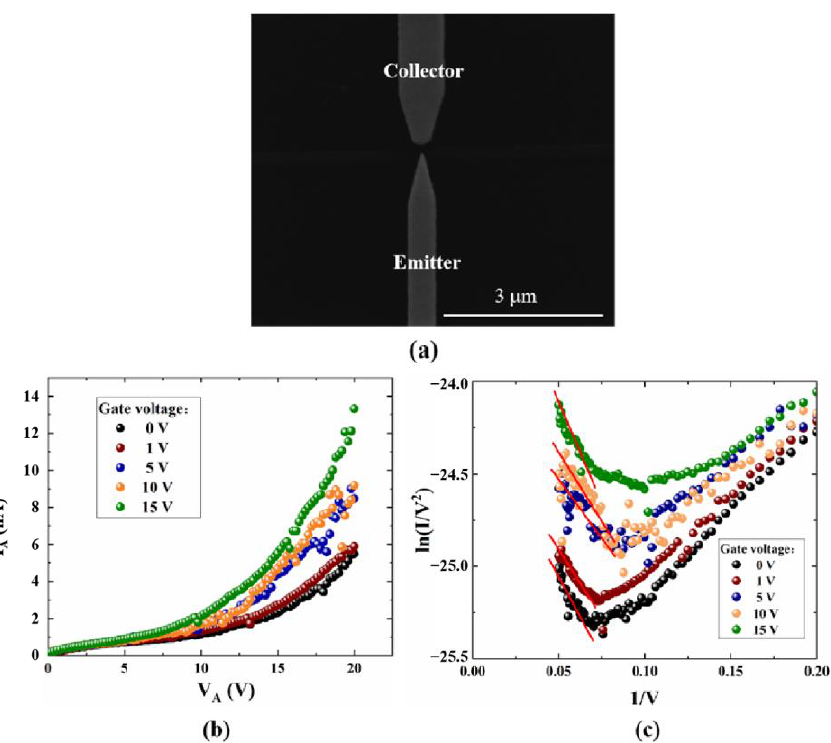
Figure 7. The electrical performance test curves, ( a ) SEM images of back-gate NVCT, ( b ) emission current versus collector voltage, and ( c ) F-N fitting